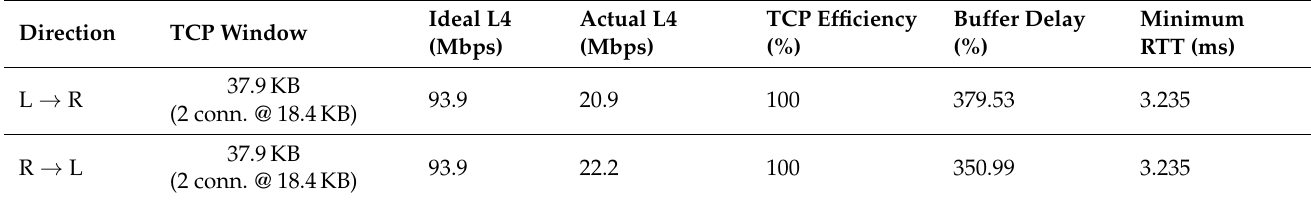
Table 3. Achieved results of RFC 6349